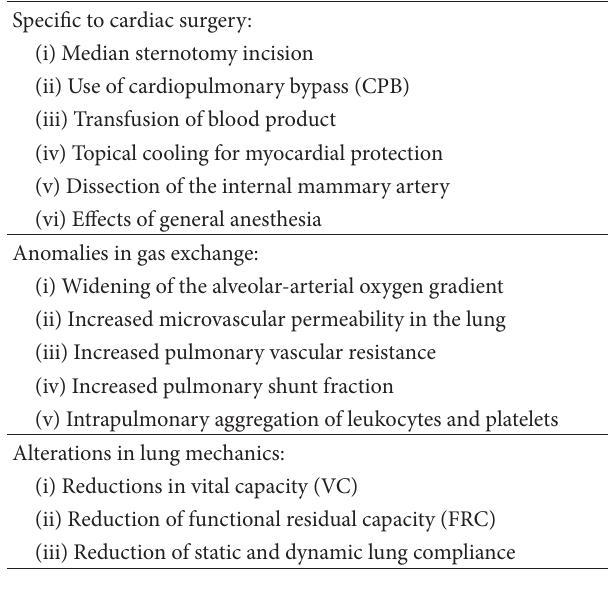
Table 1: Pathogenetic mechanisms of postoperative pulmonary dysfunction